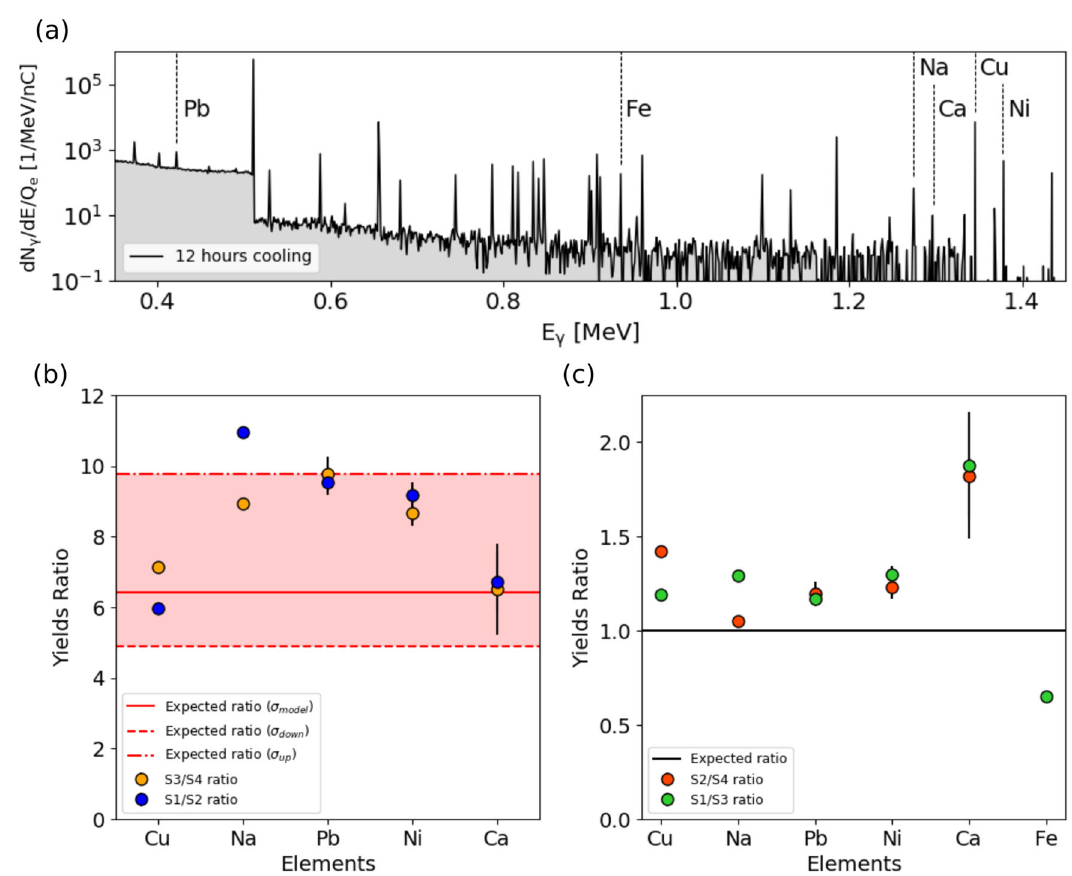
Fig. 5 Comparison between Monte Carlo simulations and model results. a Photon energy spectrum from Monte Carlo simulation S 1 was obtained from sample irradiation after 12 h rest time and for 3 h measurement time. The considered characteristic γ -ray peaks for the elements are identi fi ed by the dashed lines. b Ratio between the intensities of simulations S 1/ S 2 (blue point) and S 3/ S 4 (yellow points) for each element. The continuous red line corresponds to the ratio predicted by the model assuming a normalized cross section centered at 17 MeV. The dashed upper and lower red lines correspond to the ratio predicted by the model assuming normalized cross sections centered in 20 and 15 MeV, respectively. c Ratio between the intensities of simulations S 1/ S 3 (green points) and S 2/ S 4 (red points) for each element. The black line corresponds to the value predicted by the model. The error bars are evaluated as two times the standard deviation of the data collected with the Monte